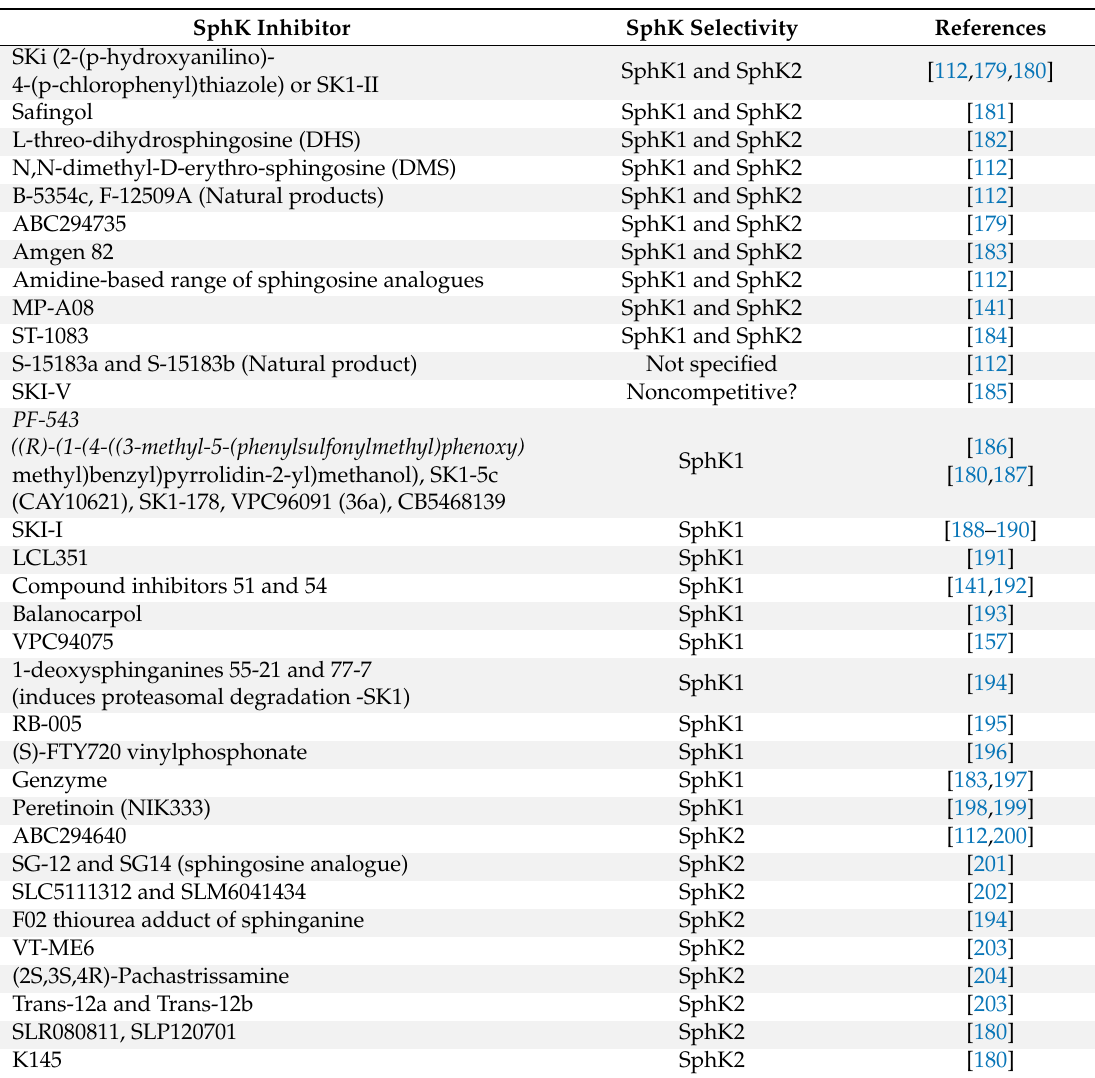
Table 2. Sphingosine kinase (SphK)